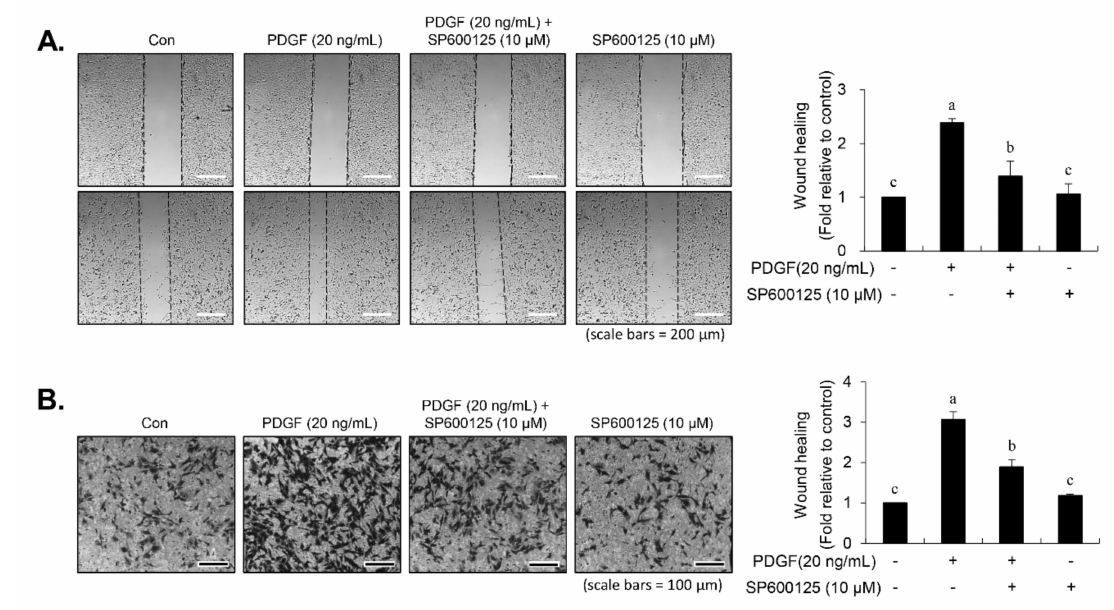
Figure 7. SP600125 inhibited PDGF-stimulated migration of VSMCs. Serum-starved cells were pre-treated for 45 min in the presence of SP600125 (10 µ M). Cells were then cultured with PDGF (20 ng / mL) for 24 h. Wound-healing assay ( A ) and transwell migration assay ( B ) were performed as described in Materials and Methods. Values are expressed as the mean ± SD values of three independent experiments. The di ff erent letters indicate significant di ff erences between the groups ( p <